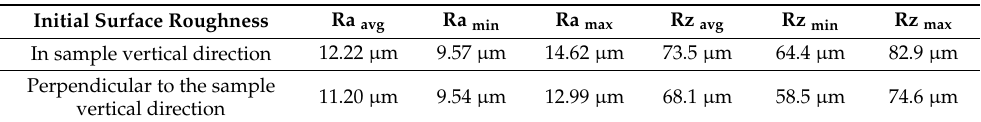
Table 1. Initial mean surface roughness Ra and Rz of the vertical printed sample (fabrication angle α = 90 ◦ ), used for the parameter investigations.